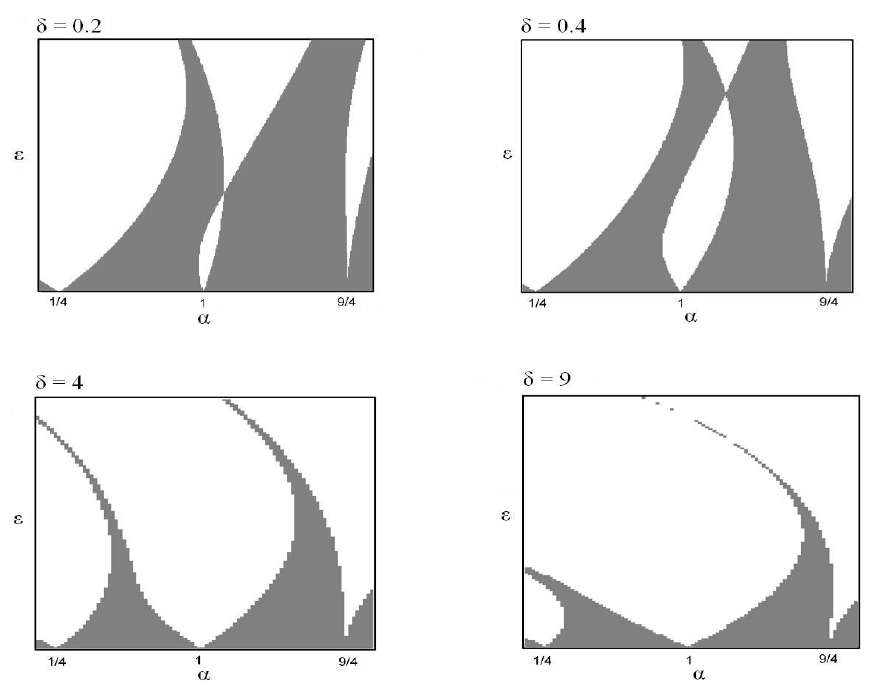
Figure 1. Stability diagrams for the extended version of the Mathieu equation as δ is